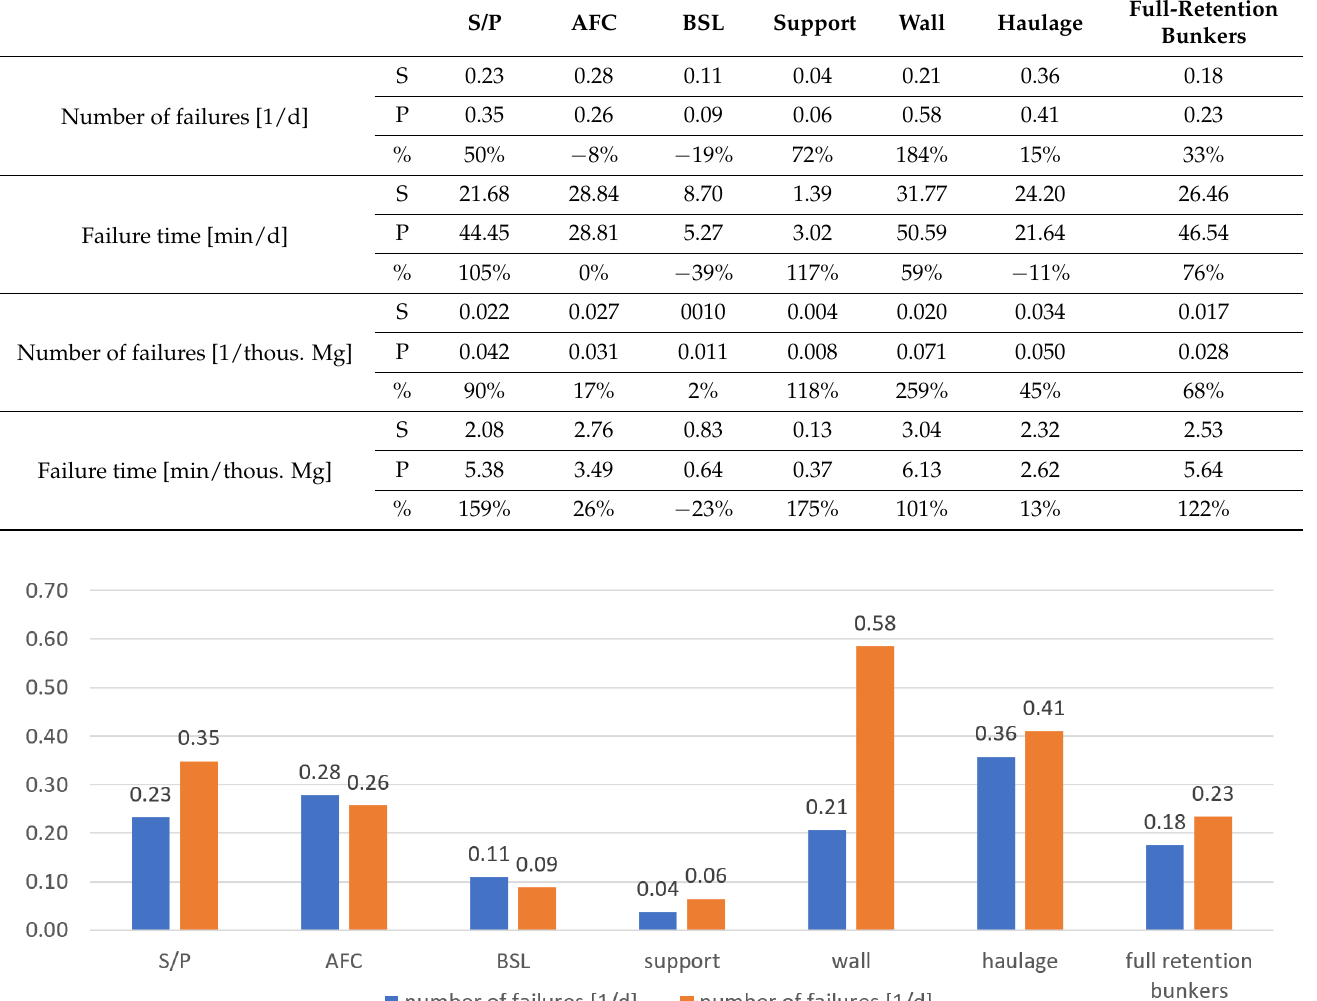
Table 6. Comparison of the total failure rates for shearer (S) and plow (P) longwalls. S/P Support Wall Haulage S/P AFC BSL Support Wall Haulage